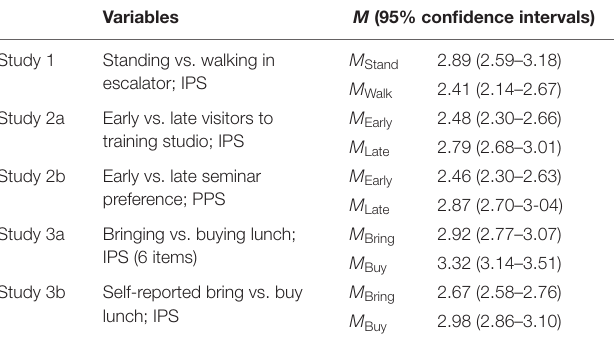
TABLE 3 | Results, present